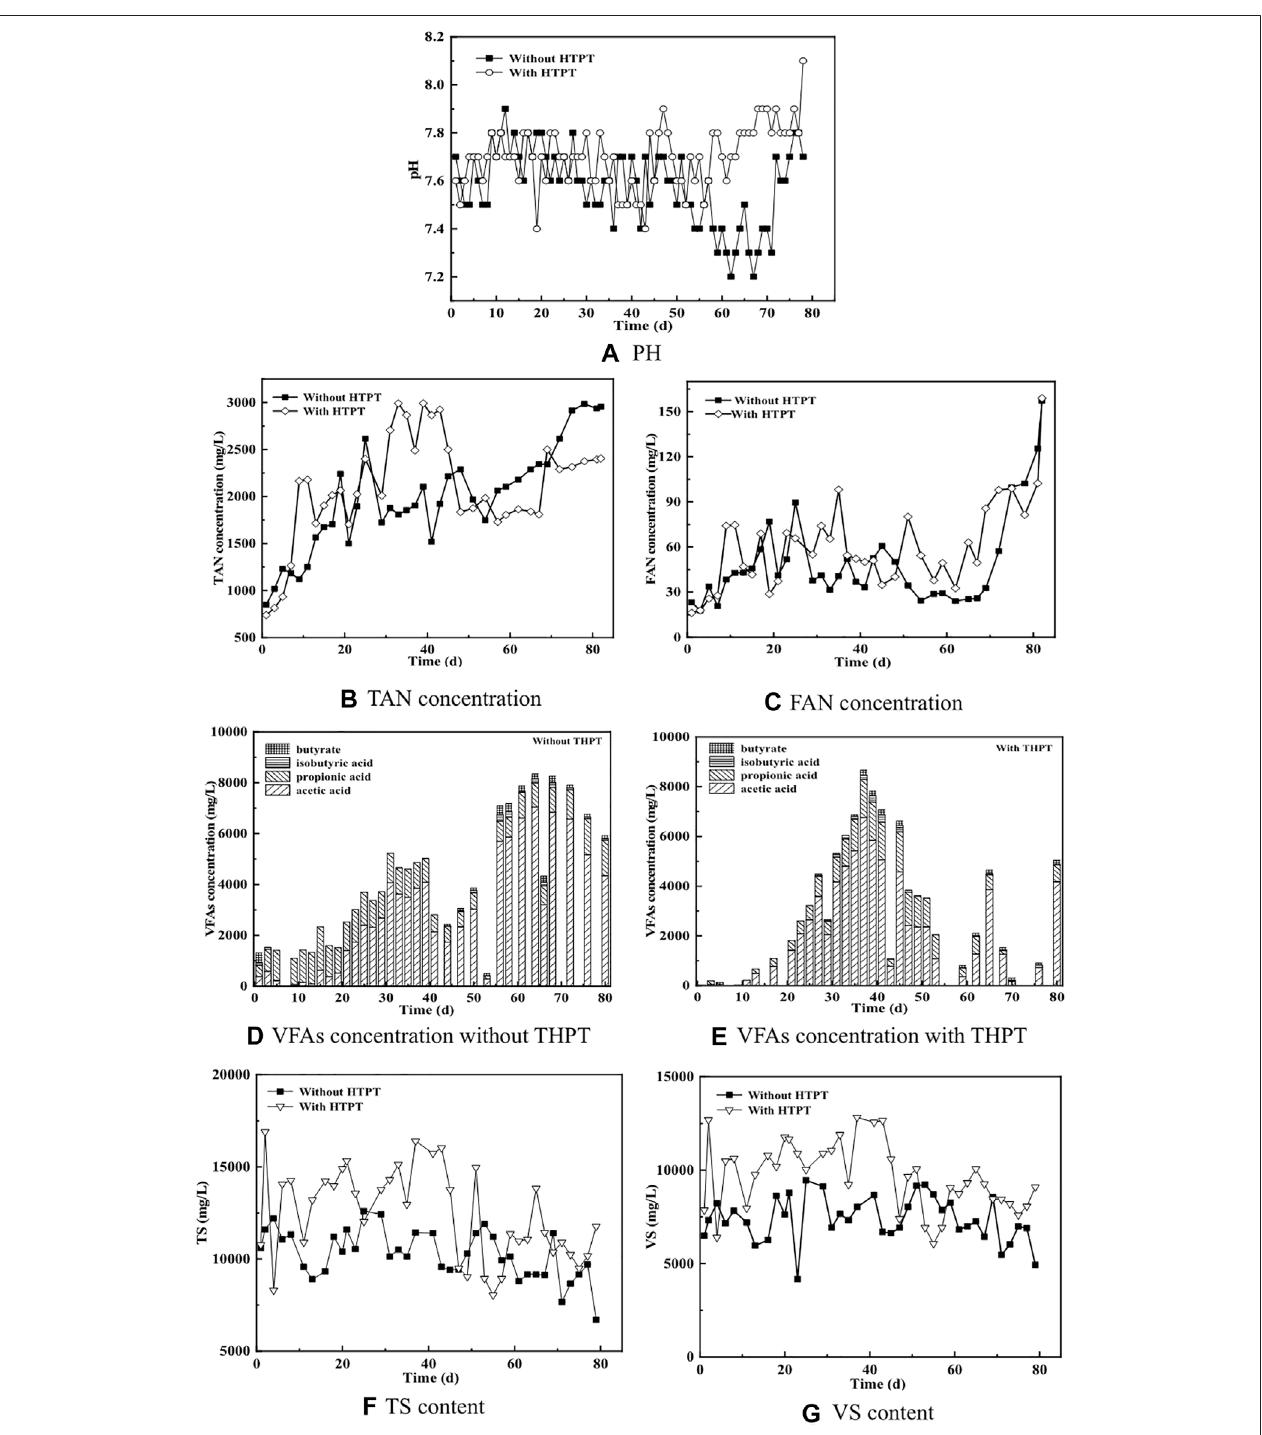
FIGURE 4 | Effects of THPT on the process indicator parameters of continuous AD of tofu. (A) The pH; (B) the TAN concentration; (C) the FAN concentration; (D and E) the VFAs concentration without and with THPT, respectively; (F) the TS content; and (G) the VS content of the liquid digestates.